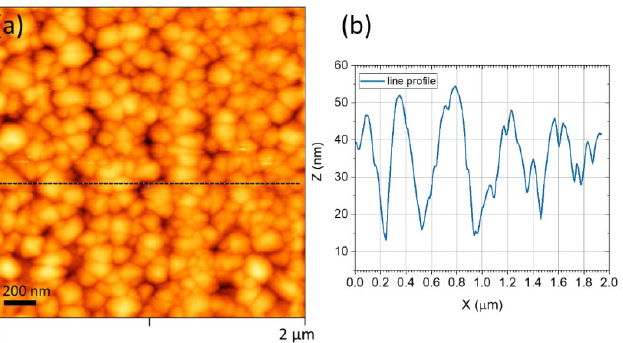
Figure 5. ( a ) AFM surface morphology and ( b ) line scan (across the dashed line) of the laser ‐ ablated ZnO nanoparticle ‐ coated U ‐ bent optical fiber.